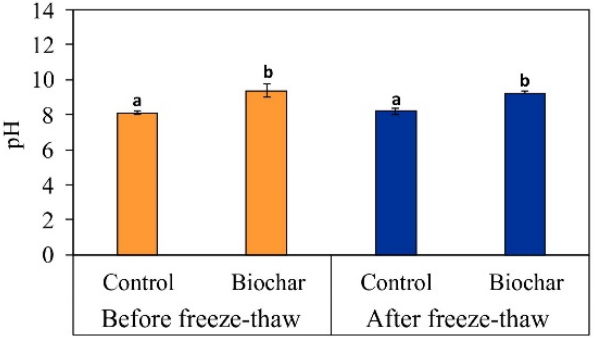
Figure 3. Effect of biochar amendment on soil pH value before and after freeze–thaw of a phytostabilized metal/metalloid-contaminated soil cultivated with Lolium perenne L. See Materials and Methods for detail on experimental set-up. Data are mean ± standard deviation ( n = 3). Values followed by different letters differ significantly (ANOVA followed by Tukey’s HSD test, p < 0.05).